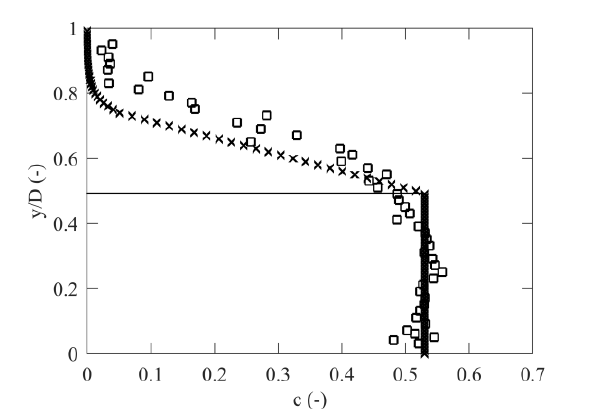
Fig. 4. Distribution of granular concentration at velocity slightly above deposition limit for flow of SP090 slurry ( C vd,max = 0.37) at pipe inclination of -15 deg, V m = 1.1 m.s -1 , C vd = 0.19 . Legend: square = experiment, x = model prediction.